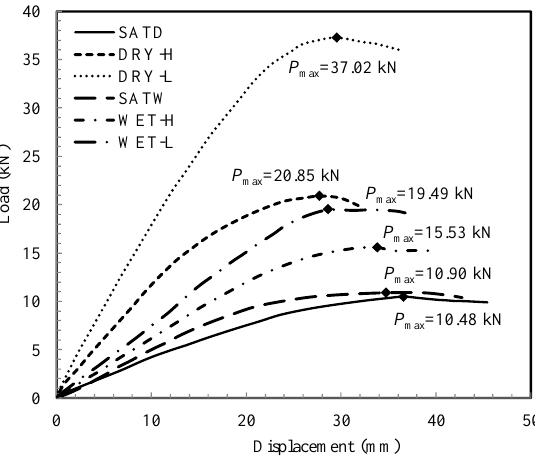
Figure 6. Plate load test results. Table 1. Measured and estimated bearing capacities for PLTS under different conditions.